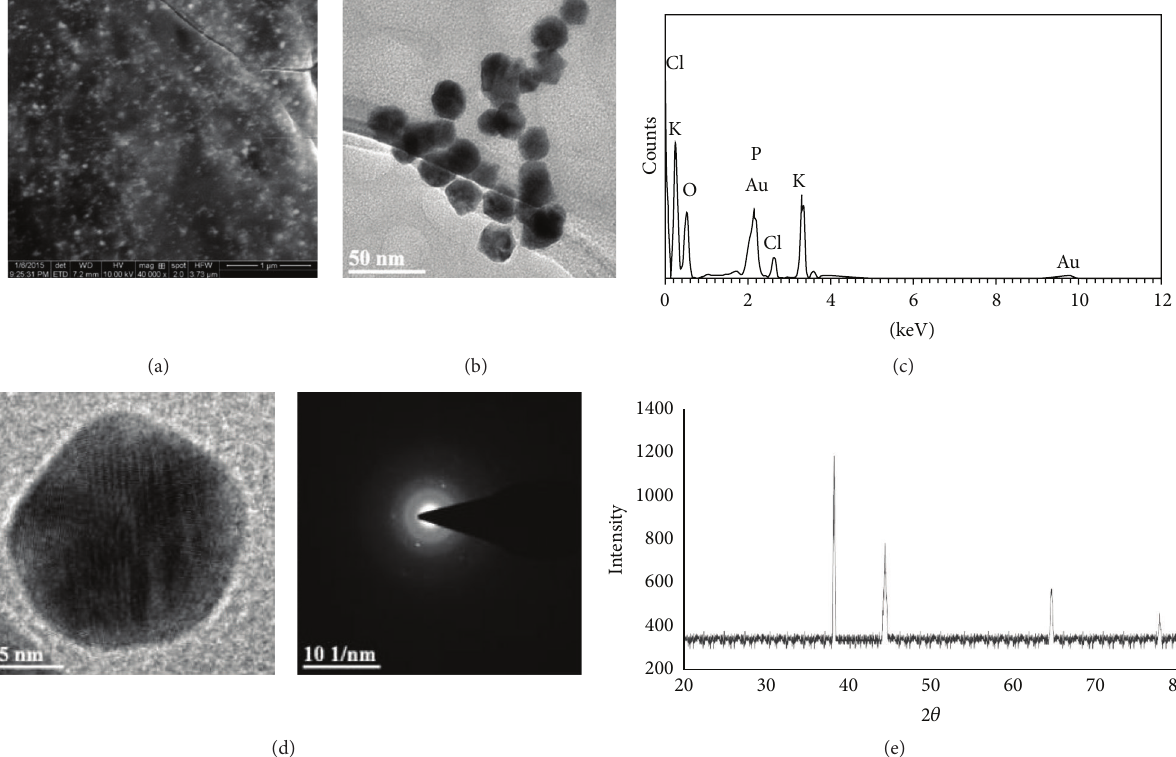
Figure 4: Characterization of GNPs described by SEM (a) and TEM (b) micrograph, ESD spectrum (c), SAED (d), and XRD (e) pattern.